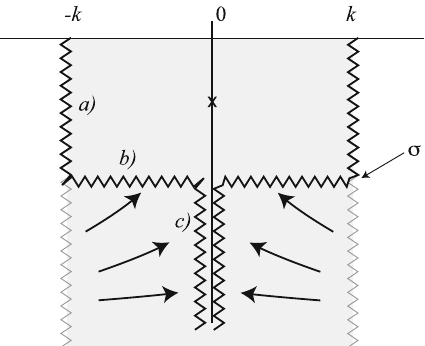
Fig. 6 A particular deformation of the branch cuts of the generating function H a , defined in Eq. (66) and the surrounding text